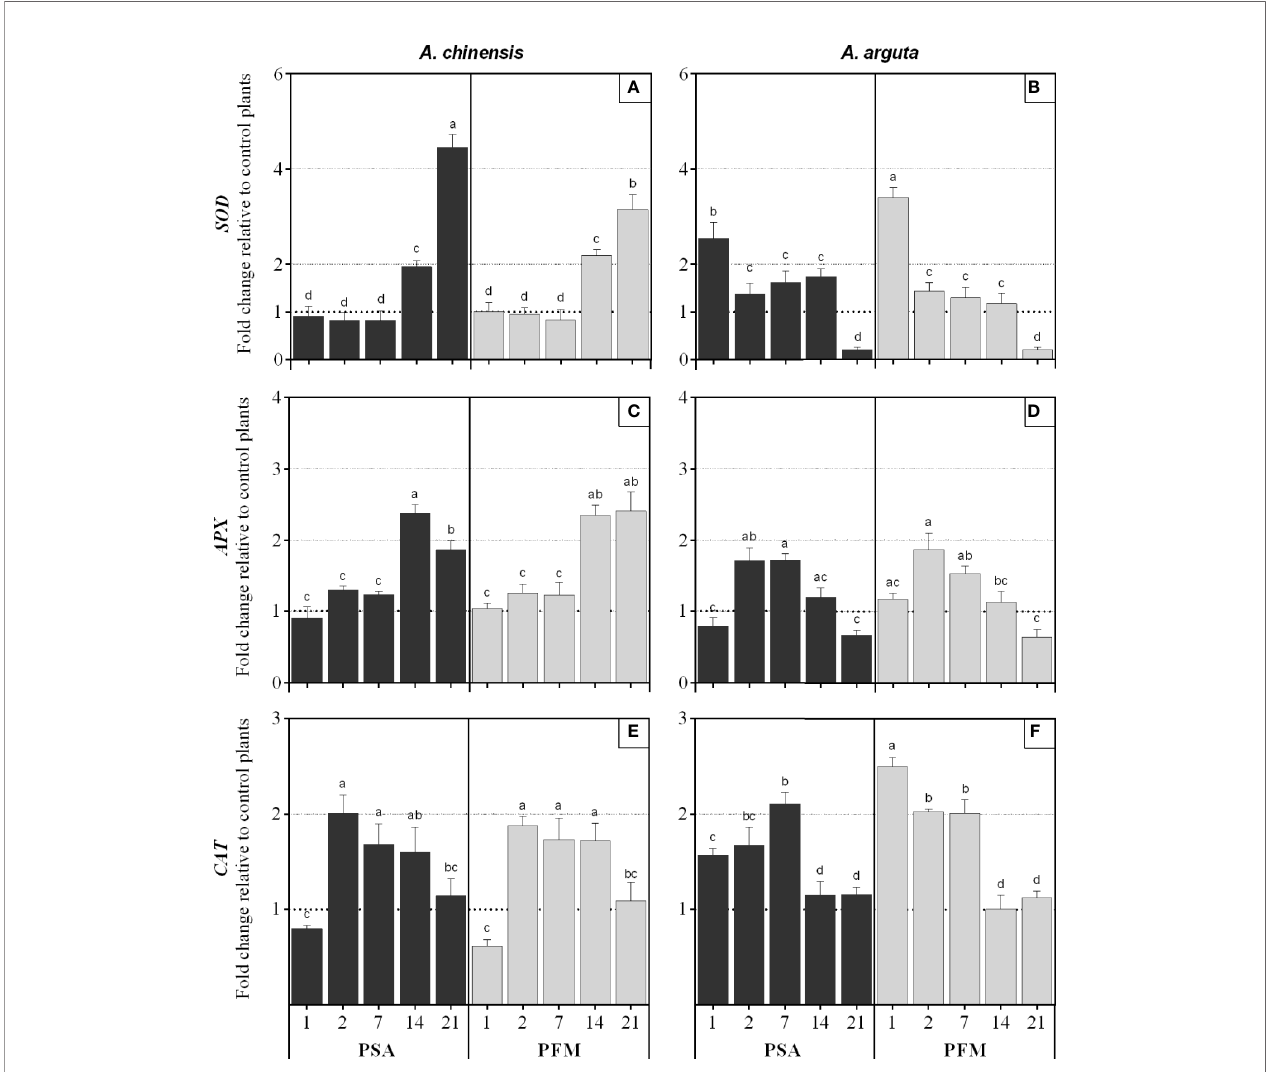
FIGURE 4 | Relative fold of expression of SOD (superoxide dismutase), APX (ascorbate peroxidase) and CAT (catalase) genes in Actinidia chinensis var. deliciosa cv. ‘ Hayward' (panels A , C and E , respectively) and in A. arguta var. arguta cv. ‘ Weiki ’ plants (panels B , D and F , respectively) inoculated with Pseudomonas syringae pv. actinidiae (Psa) or P. syringae pv. actinidifoliorum (Pfm) registered 1, 2, 7, 14 and 21 days post inoculation (dpi). Columns represent the mean of three independent replicates (consisting in the pool of three plants each) ± standard error. Within the same kiwifruit species, columns with different letters are signi fi cantly different at p < 0.05. One-fold change represents no relative change in gene expression, as compared with non-inoculated control